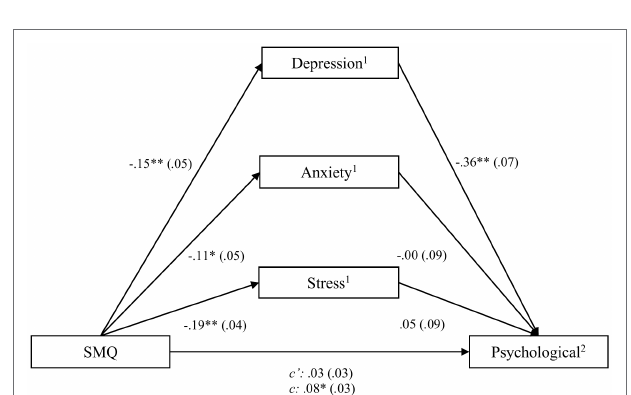
FIGURE 2 | Process outcomes including CHIME and physical health. * p < 0.05; ** p < 0.01, 1 assessed by the DASS-21, 2 assessed by the WHOQOL- BREF. For simplicity, the covariate, recruitment site, is not included in this and the following figures, although being included in the analysis. For more detailed results, see Table 5